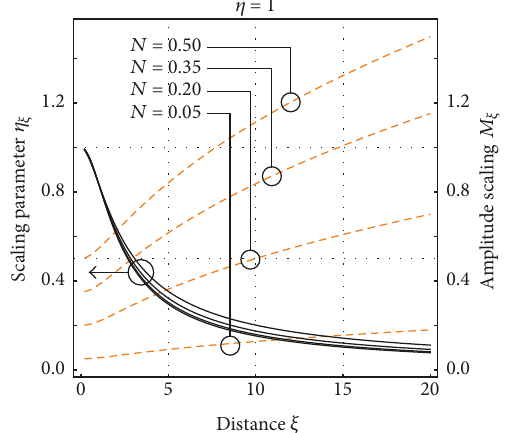
Figure 2: Evolution of amplitude scaling factor 𝑀 𝜉 (orange, dashed curves) and scaling parameter 𝜂 𝜉 (black solid curves) with distance, for 𝑁 = 0.05 , 0.2 , 0.35 and 0.5 , as